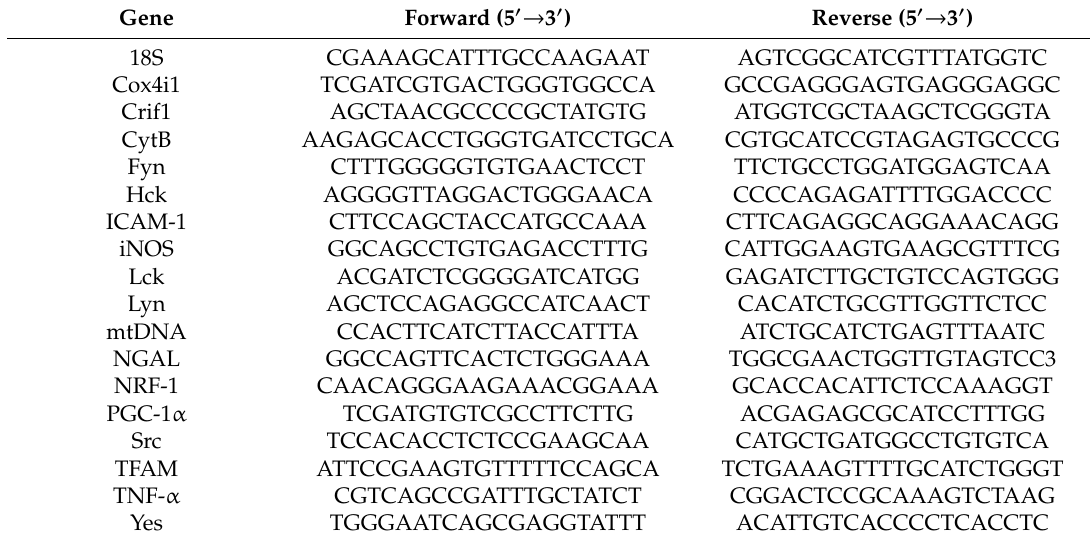
Table 1. Primer sequences used for real time RT-PCR analysis. Gene Forward (5 (cid:48) → 3 (cid:48)